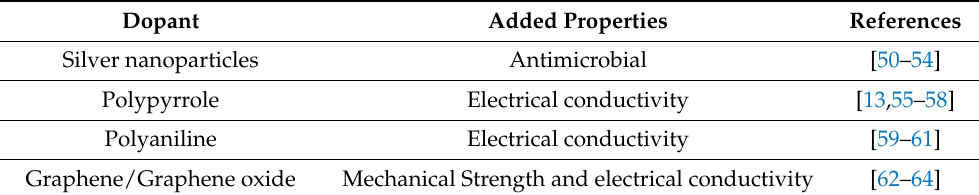
Table 2. Some dopants and additives used to impart different characteristics to BC.